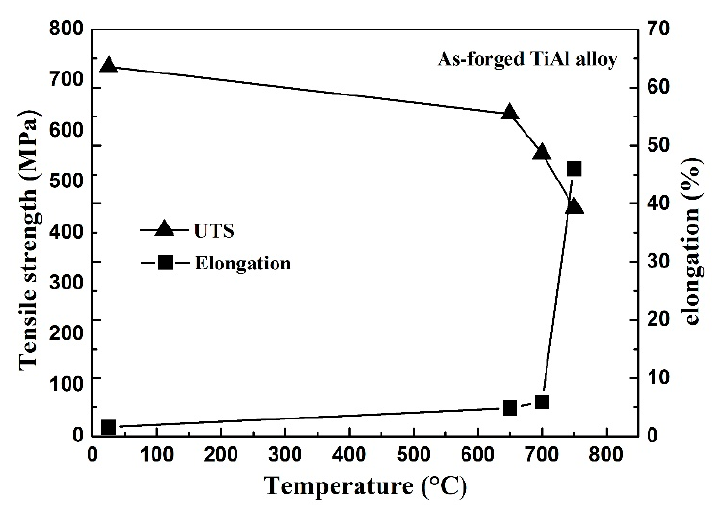
Figure 6. The dependence of tensile strength and elongation on the temperature.